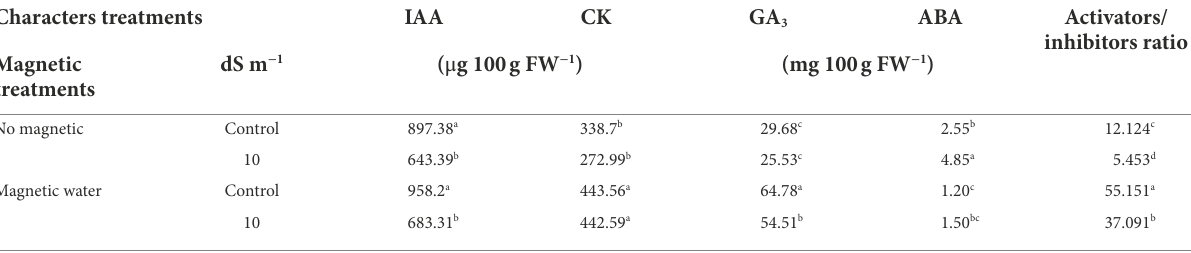
TABLE 6 Effect of seawater stress levels, magnetic treatment on concentration of plant phytohormones in the shoot of wheat plants during the second growing season. Characters treatments